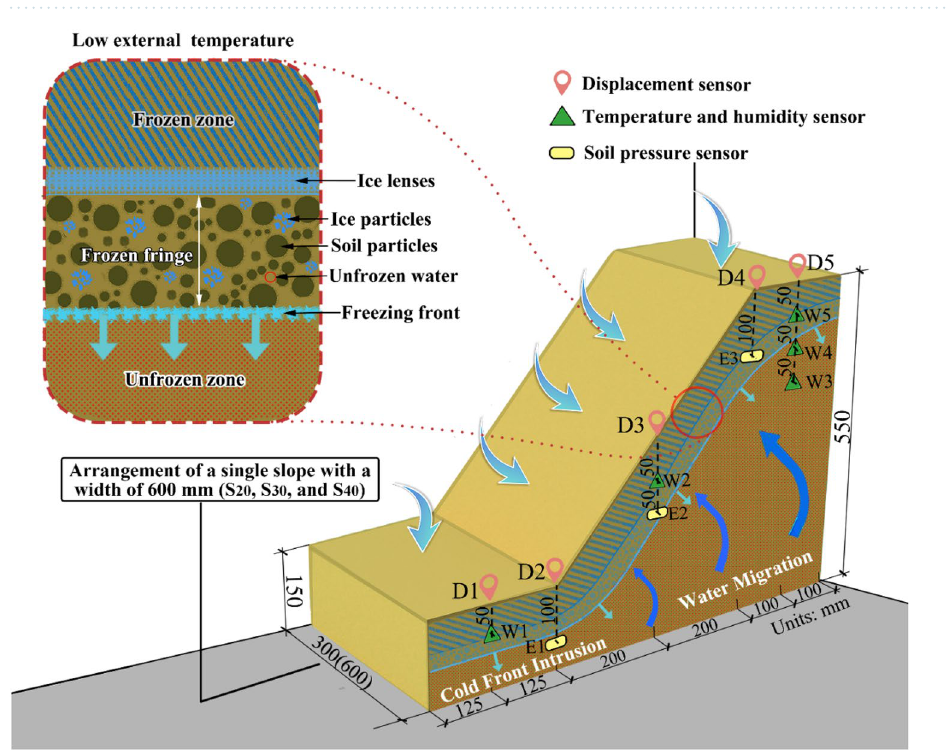
Figure 2. Slope freezing model and freeze–thaw monitoring